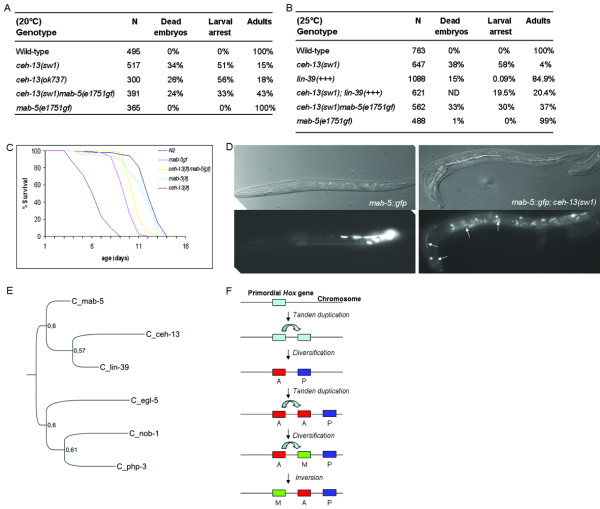
Increased activity of lin-39 and mab-5 can rescue some defects in ceh-13 mutant animals. A-B, A gain-of-function mutation in mab-5, e1751, suppresses lethality in ceh-13(-) mutants. Note that most of the double mutant animals look superficially normal. B, Extra copies of lin-39 suppress larval lethality in ceh-13(sw1) mutants. "+++" represents an integrated translational fusion LIN-39::GFP reporter that is able to rescue the Vul phenotype of lin-39 hypomorph mutants (~5%, N = 122). ND, not determined. C, mab-5(e1751gf) mutation restores the lifespan of ceh-13(-) mutants to a nearly normal level. Note that the vast majority of ceh-13(-) single mutants die at early stages of development (Figure 8A, B), and the survivals (escapers) live only few days as adults (i.e., they are extremely short-lived). For double mutants, normal looking L4 stage larvae were selected and then scored for survival (yellow curve). Samples were assayed in triplicates. For ceh-13(sw1) single mutants, ~70 mutant escapers were examined in each assay. For the other strains, 150-150 animals were scored in each assay. p < 0.001, when ceh-13(lf)mab-5(gf) double mutants were calculated to ceh-13(lf) single mutants by pair-wise comparisons, and p > 0.5 when double mutants were compared to the wild type. The log-rank test was used for comparison. N2 indicates wild-type. D, mab-5::gfp expression in wild-type (left panel) vs. ceh-13(sw1) mutant (right panel) background at the L1 larval stage. Nomarski pictures on the top, corresponding fluorescent images at the bottom. White arrows indicate cells that are gfp-positive. E, Phylogenetic tree of homeodomain sequences of the C. elegans Hox genes. The tree was generated by the Bayesian phylogenetic method. Numbers at the nodes correspond to the probability - i.e., clade credibility - of each node (from 0 to 1). F, Model for the early evolution of the nematode Hox cluster. A ceh-13-like primordial Hox gene underwent a tandem gene duplication event in an early phase of animal evolution, leading to the ancestors of the primitive anterior and posterior Hox genes. A subsequent tandem duplication of the anterior ancestor resulted in the ancestor of the middle-group Hox genes. A: anterior, P: posterior, M: Middle.